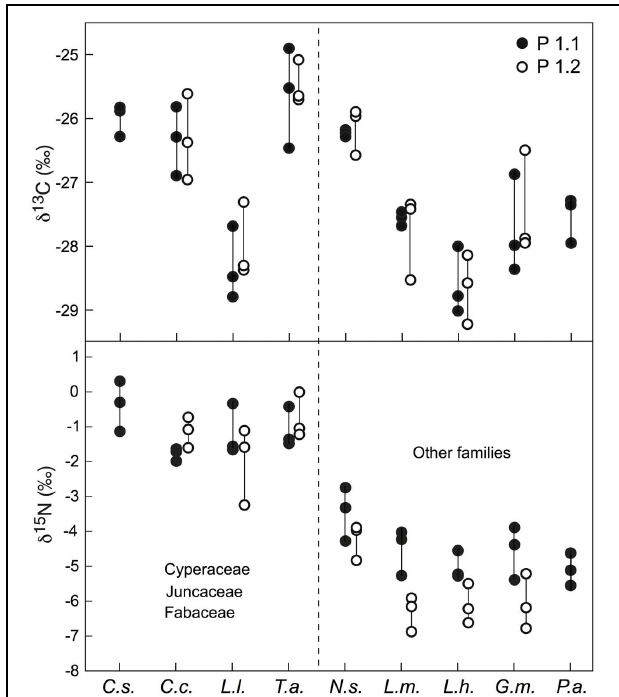
FIGURE 3 | Intra-specific variation in δ 13 C and δ 15 N among three individuals growing next to each other for nine or seven species sampled at two sites (P1.1 and P1.2). Each point represents a mixed signal from several leaves for one individual. The species effect across this set of species (based on values for three individuals per species) was significant in both plots at p < 0.01 for both δ 13 C and δ 15 N. Cs , Carex sempervirens ; Cc , Carex curvula ; Ll , Luzula lutea ; Ta , Trifolium alpinum ; Ns , Nardus stricta ; Lm , Ligusticum mutellina ; Lh , Leontodon helveticus ; Gm , Geum montanum ; Pa ,